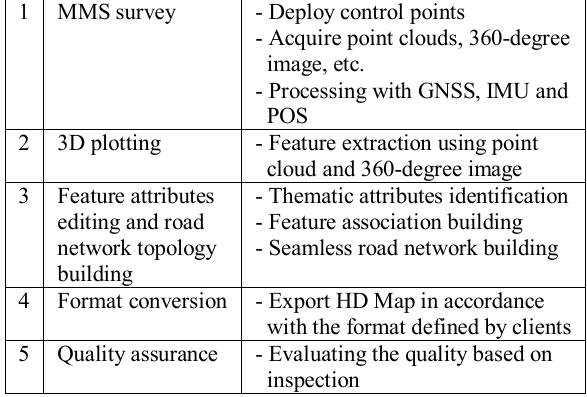
Table 1. Key steps of our large-scale production